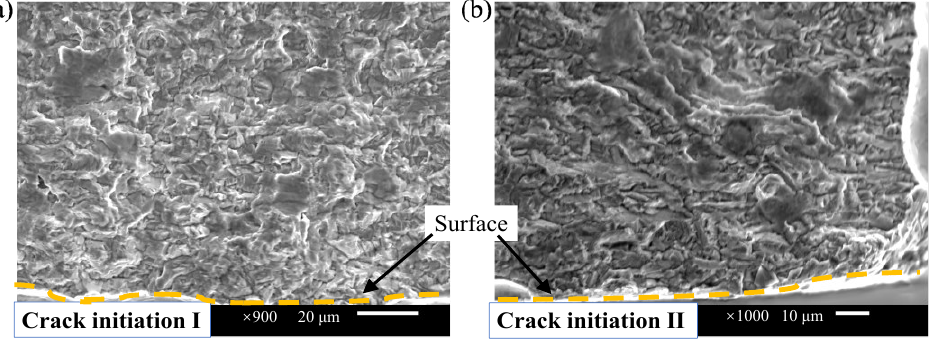
Figure 10. Pure bending fracture morphology: (σ a = 335 MPa, N f = 1.47 × 10 8 ) crack initiation morphology: ( a ) initiation I; ( b ) initiation II.